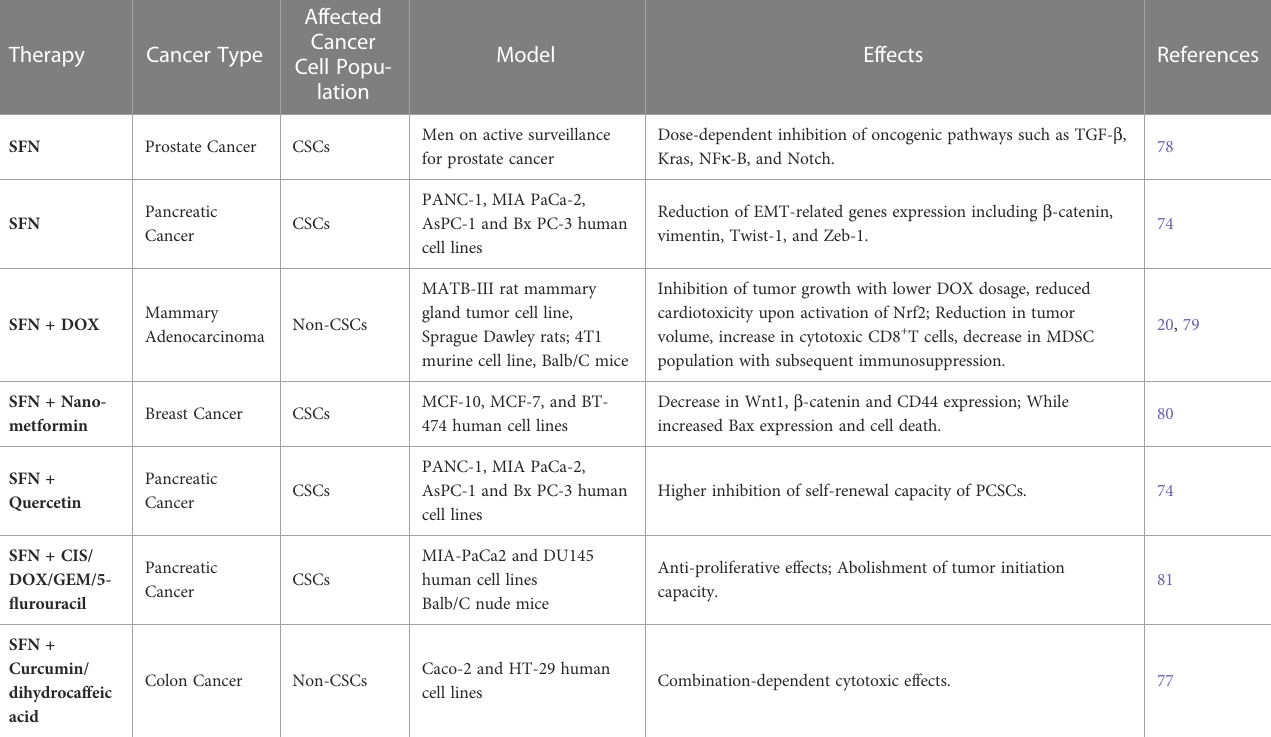
TABLE 1 Therapeutic approaches using sulforaphane for treating different tumors and its effects.